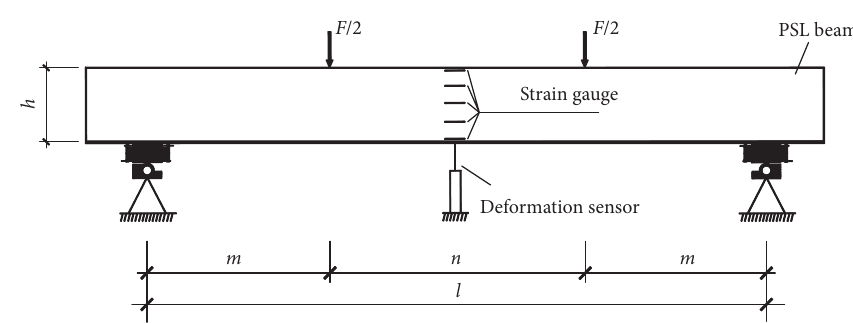
Figure 5: 4-point bending test.